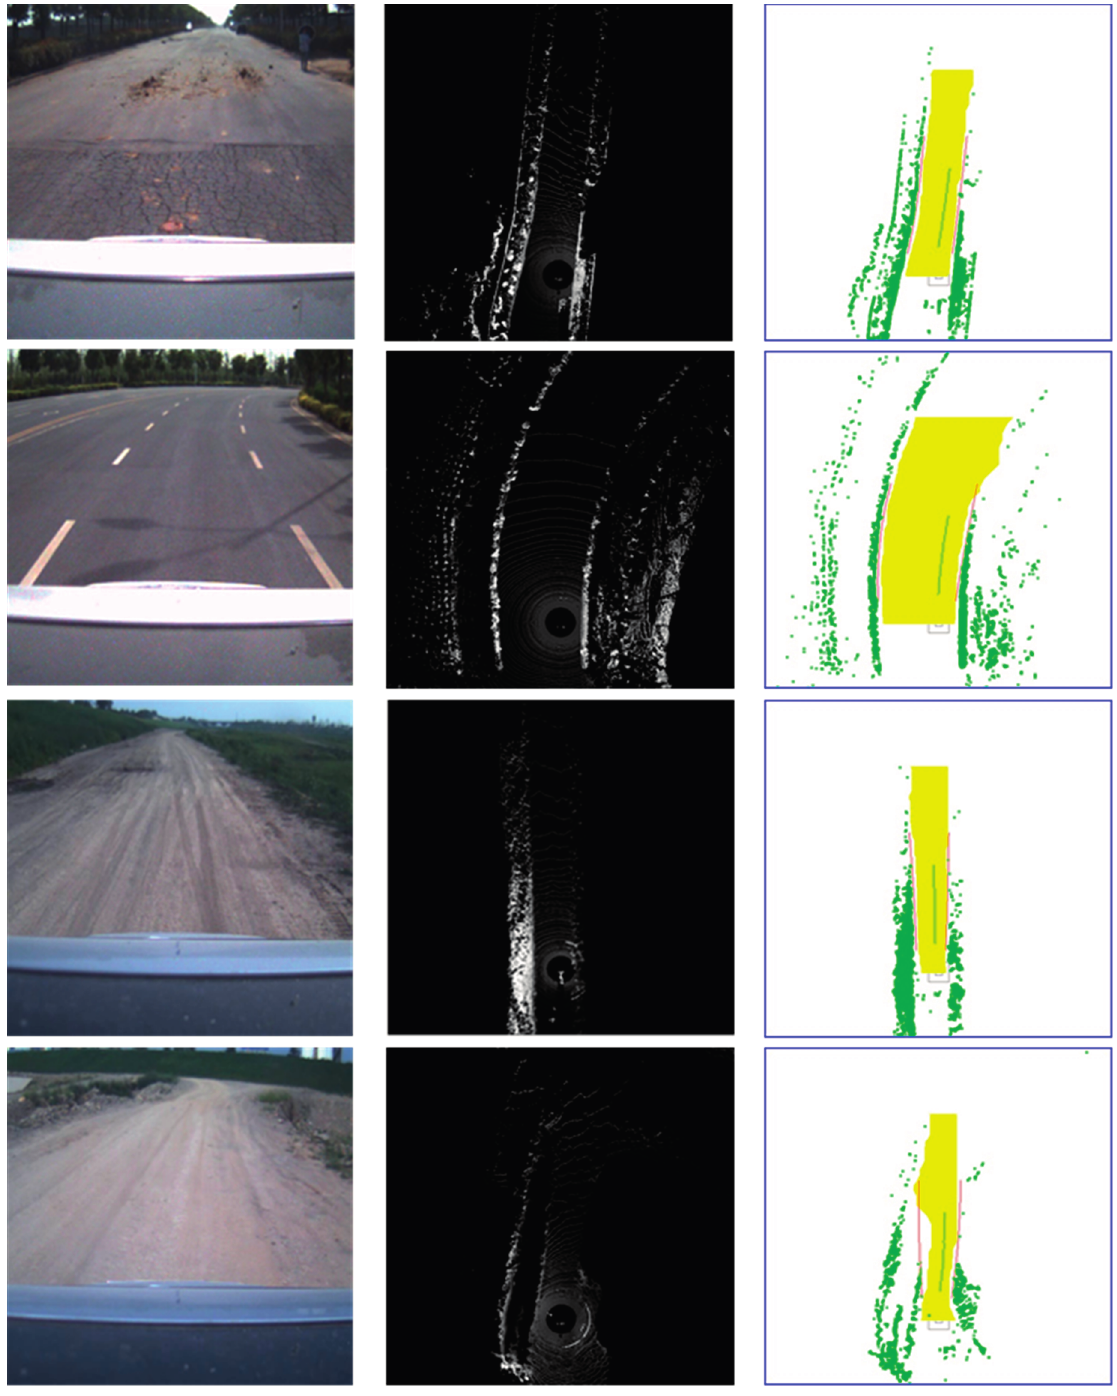
Figure 7. ( Left column ) Original image taken by a camera; ( Middle column ) Original grid map obtained by the Velodyne LIDAR; ( Right column ) Ground segmentation and curb fitting